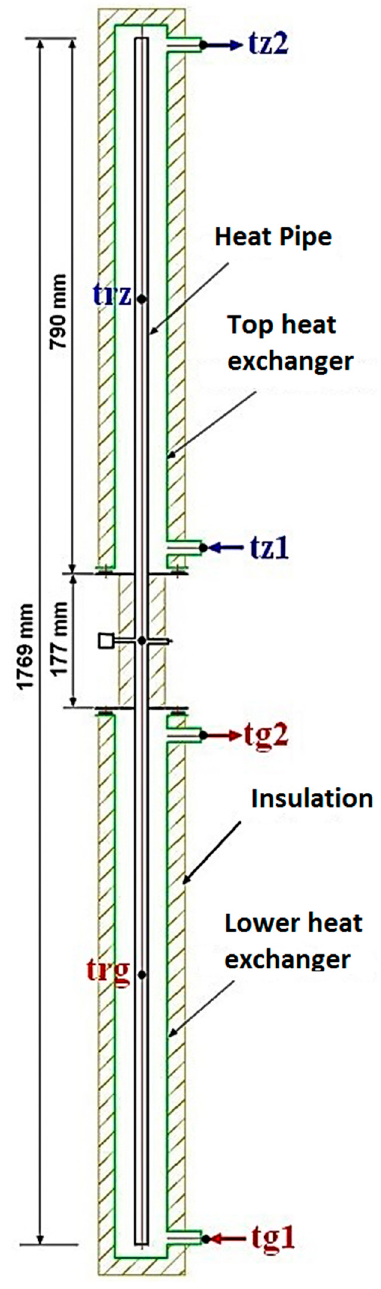
Figure 2. Scheme of the installation of the heat pipe at the measuring stand with temperature measurement points [6].